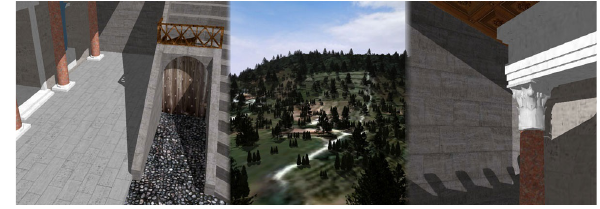
Figure 2. Light-Space shadow maps scalability